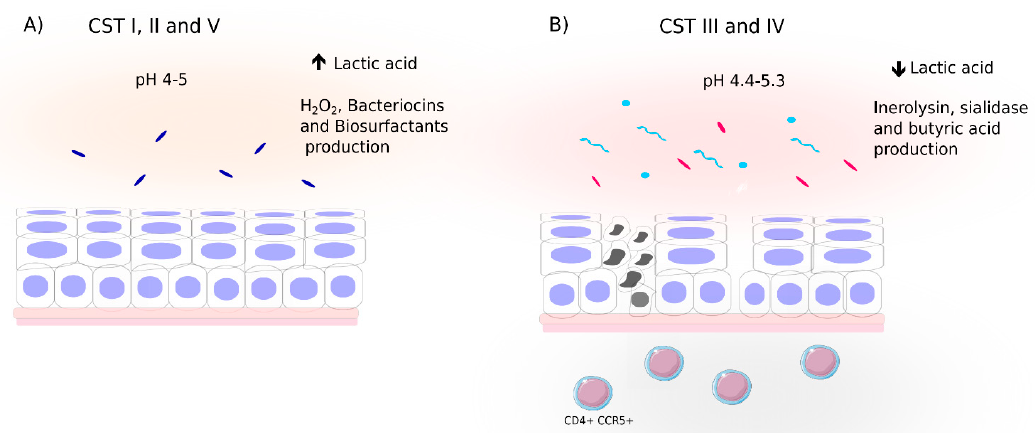
Figure 2. Bacterial bioproducts modulate cervical microenvironment. Bacterial cervical communities named CSTs (community state types) are displayed on the top of the Figure ( A , B ) in roman numerals (I, II, III, IV). ( A ) CST I, II, and V contain dominant Lactobacillus (non- iners ) species (dark blue rods) and produce high level of lactic acid, hydrogen peroxide, and bacterial bioproducts (bacteriocins and biosurfactants). ( B ) CST III shows the Lactobacillus iners -dominant community (pink rods) and CST IV displays bacterial high diversity (light blue rods and circles) with increased frequency of anaerobic species. They both produce less lactic acid and exhibit inerolysin, sialidase, and butyric acid production. In addition, CST III and IV modulate immune responses by induction of proinflammatory cytokine production and recruitment of CD4 + CCR5 + lymphocytes to the cervical region.